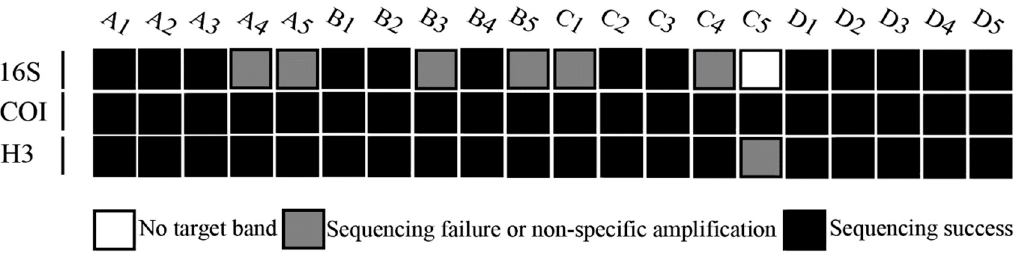
Figure 2. Amplification efficiency of 16S , COI and H3 . Three different shades of squares are used to represent the PCR and sequencing results. The code in this figure corresponds to the code in Table 1.